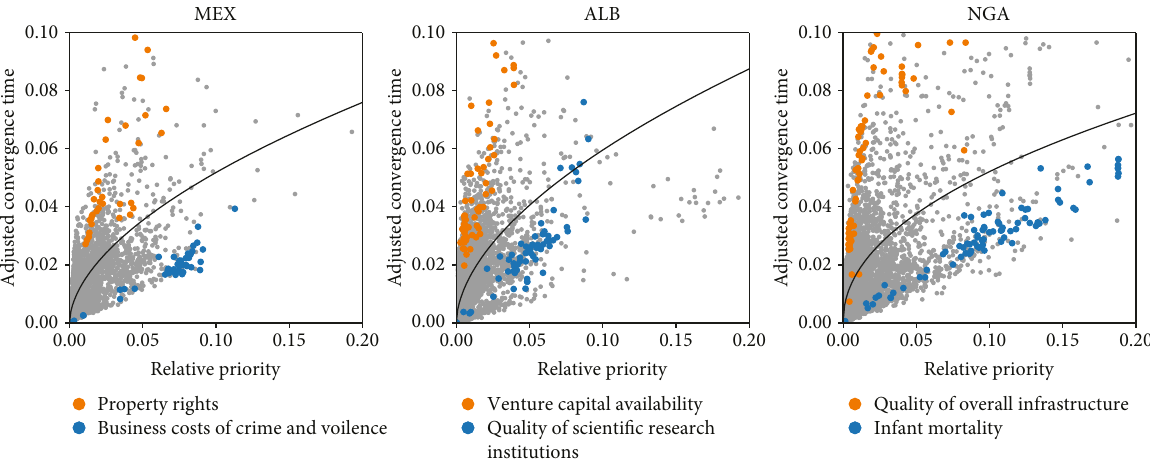
Figure 7: The most (blue) and the least (orange) resilient development indicators for three countries.